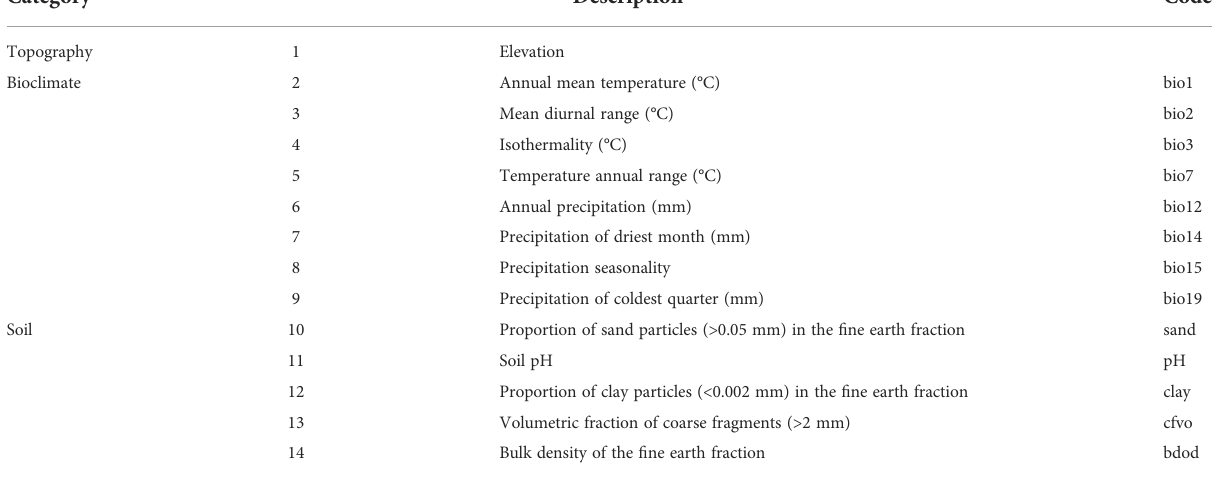
TABLE 2 Climatic variables are ultimately used to build the model.